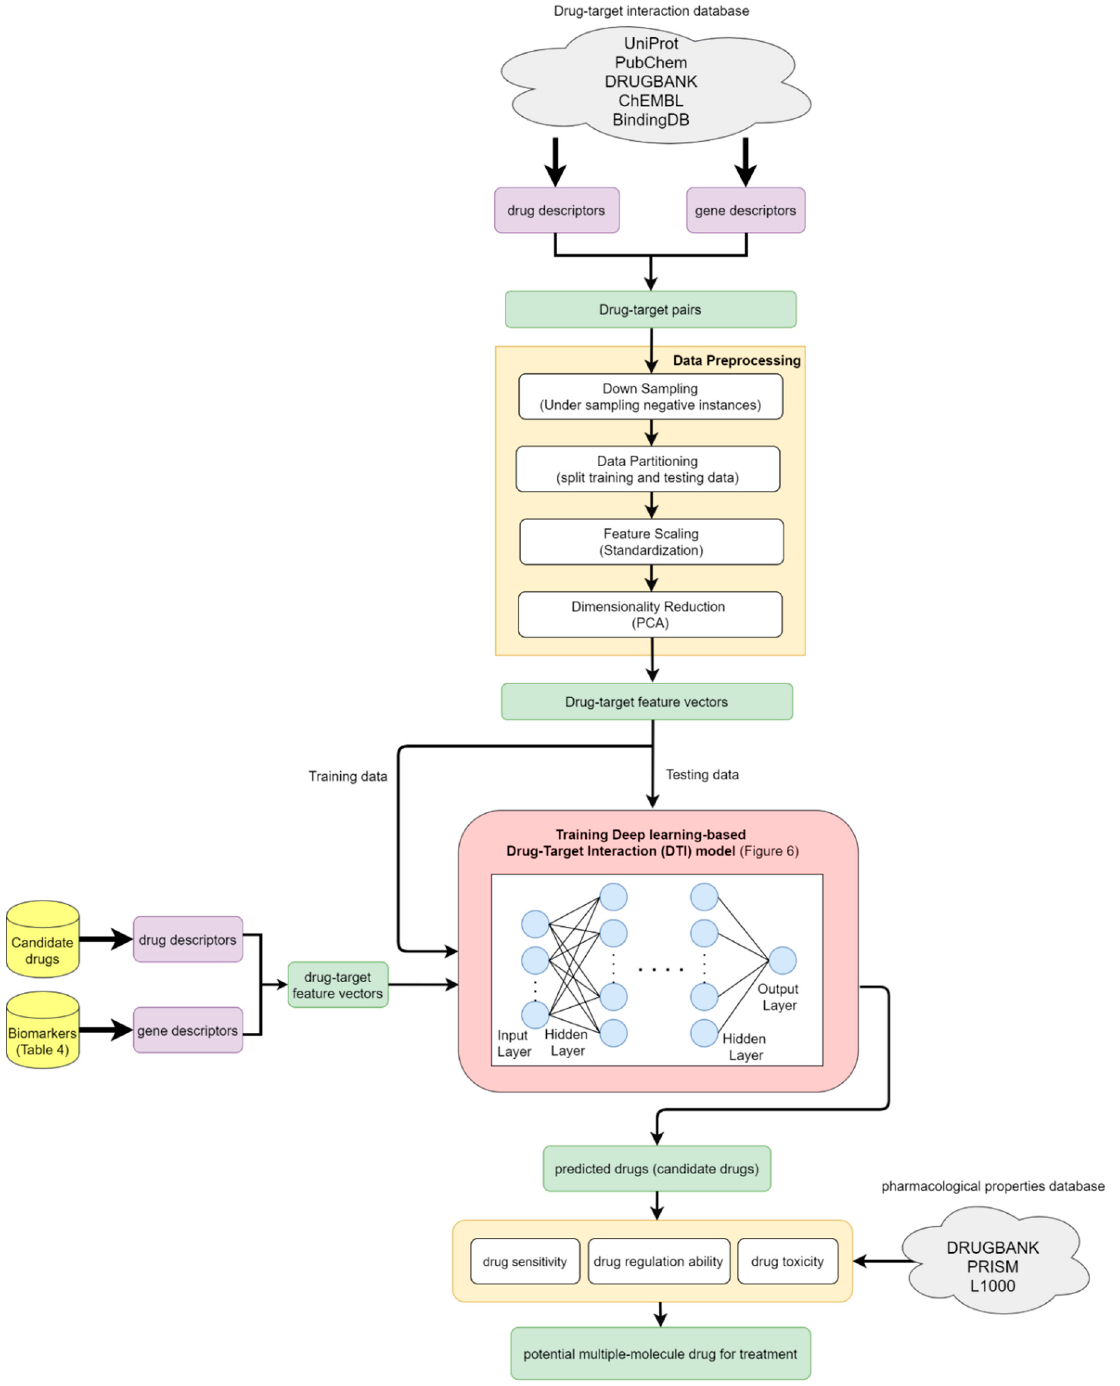
Figure 5. The flowchart of the proposed systems drug discovery and repositioning procedure. According to the potential biomarkers identified in Figure 4, we propose a systems drug discovery and repositioning method for figuring out promising multiple-molecule drug to alleviate HBV infection. First, we collected data in respect to drug-target interaction from various online databases. Then, we turned each drug and target into descriptors and assembled them into a matrix of drug-target pairs. To keep our model from poor performance, data preprocessing prior to training is indispensable. Accordingly, we adopted data preprocessing approaches including down sampling, data partitioning, feature scaling, and dimensionality reduction (For more details, readers can refer to Section 2.8.1 in Materials and Methods) based on the property of the data. After training the Deep learning-based drug-target interaction (DTI) model shown in Figure 6 with the constructed training data, we evaluated the model performance (as shown in Table 5 and